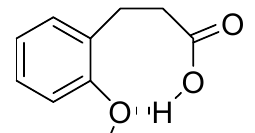
Figure 1. Proposed unfavourable electronic effect involved in the failure of the 3-(2-methylphenyl)propionic acid 3 intramolecular